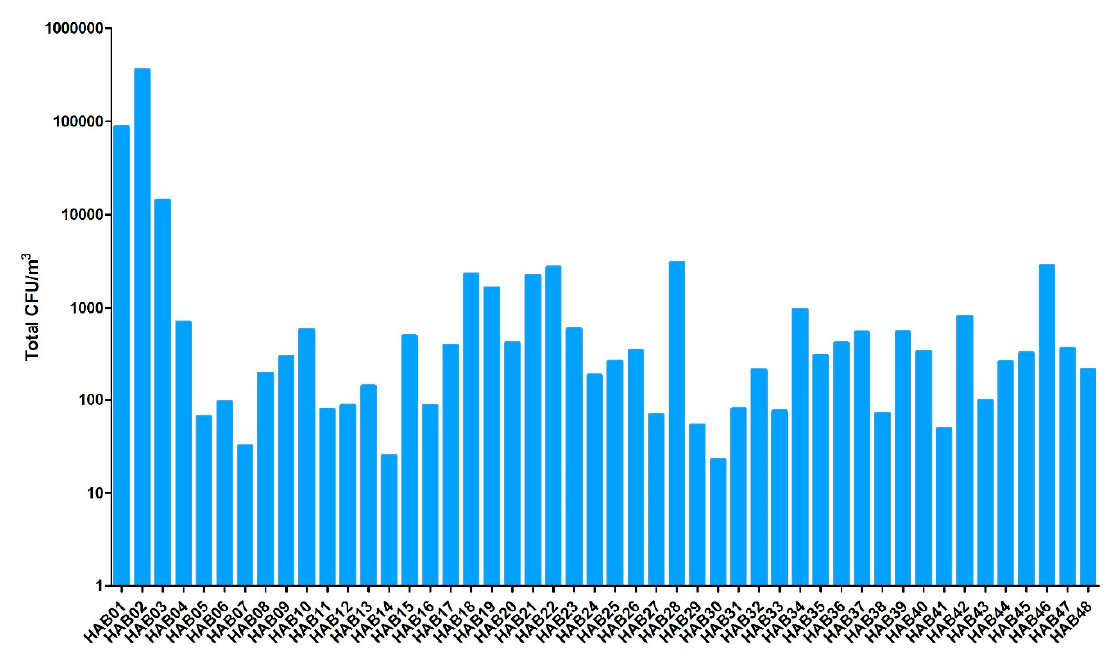
Figure 1. Total viable fungal particles concentration in the different houses (HAB01 to HAB48) included in this study.